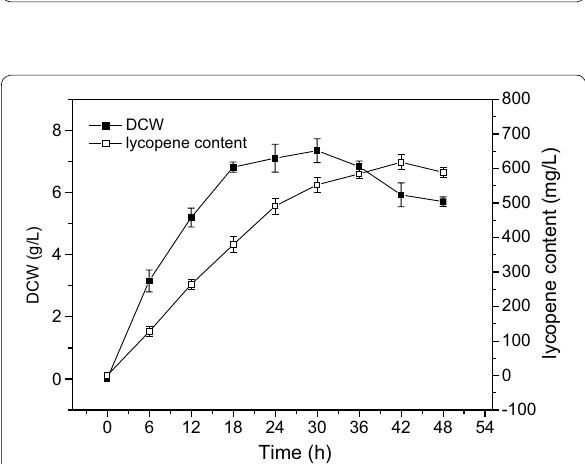
Fig. 7 Dry cell weight and lycopene yield of strain EBI with or without light. The shake flasks were exposed to LEDs (filled squares), or were incubated and without light (open circles) at 37 °C for 48 h